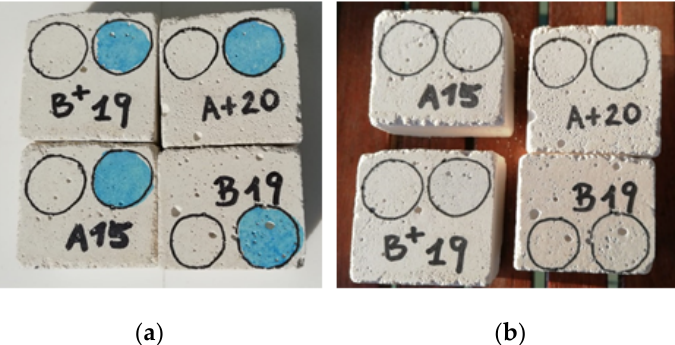
Figure 5. Methylene blue discoloration: ( a ) before and ( b ) after 1-week exposure to solar radiation.